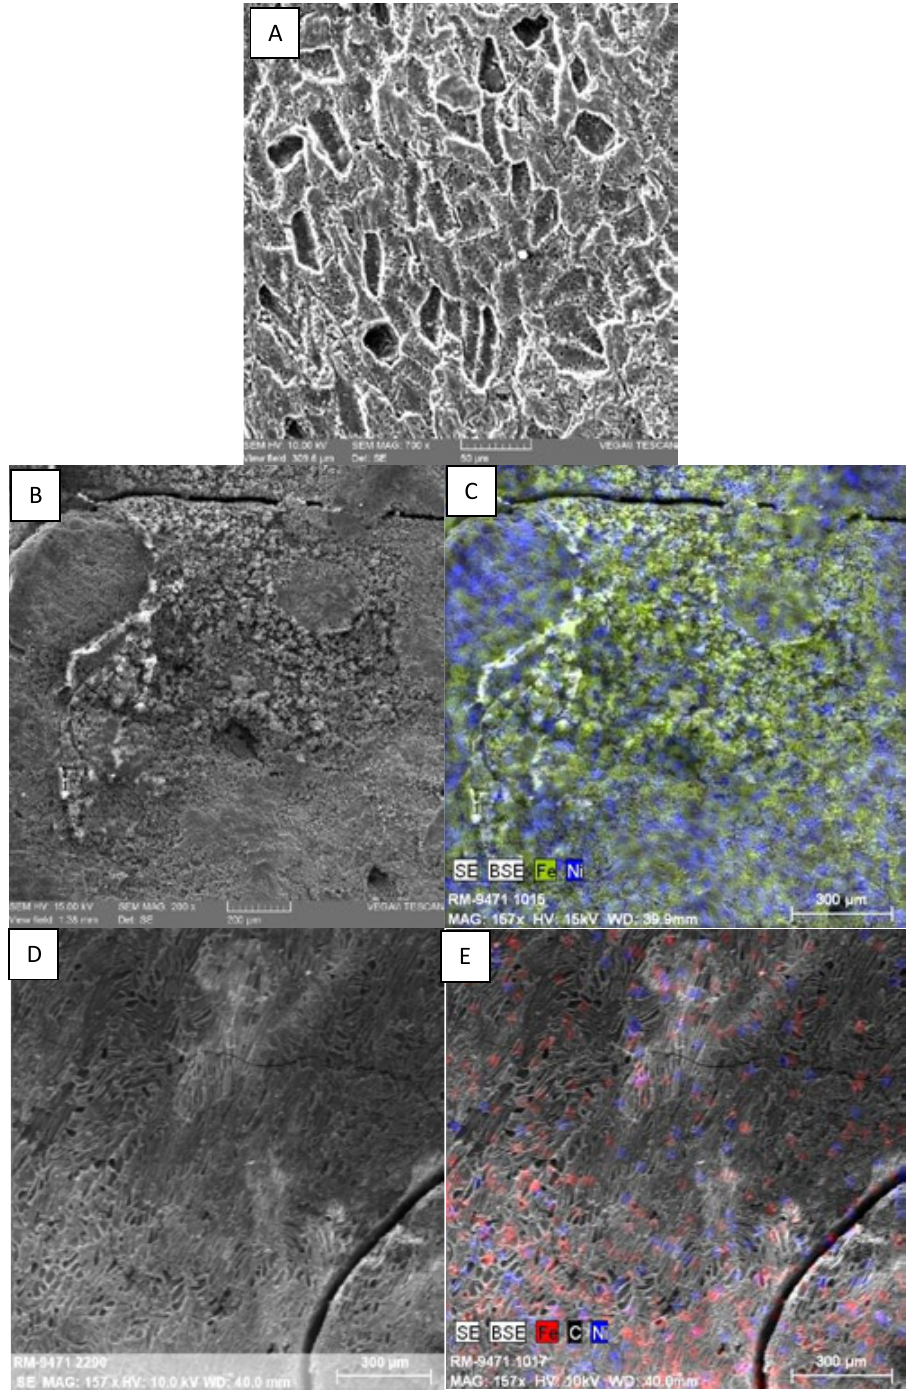
Fig. 10: Scanning electron microscopy images. (a) Activated carbon 700X, Composite R1/1 OA 157X: (b) morphological analysis, (c) elemental analysis by EDS, Composite R1/1 SH 157X: (d) morphological analysis, (e) elemental analysis by EDS